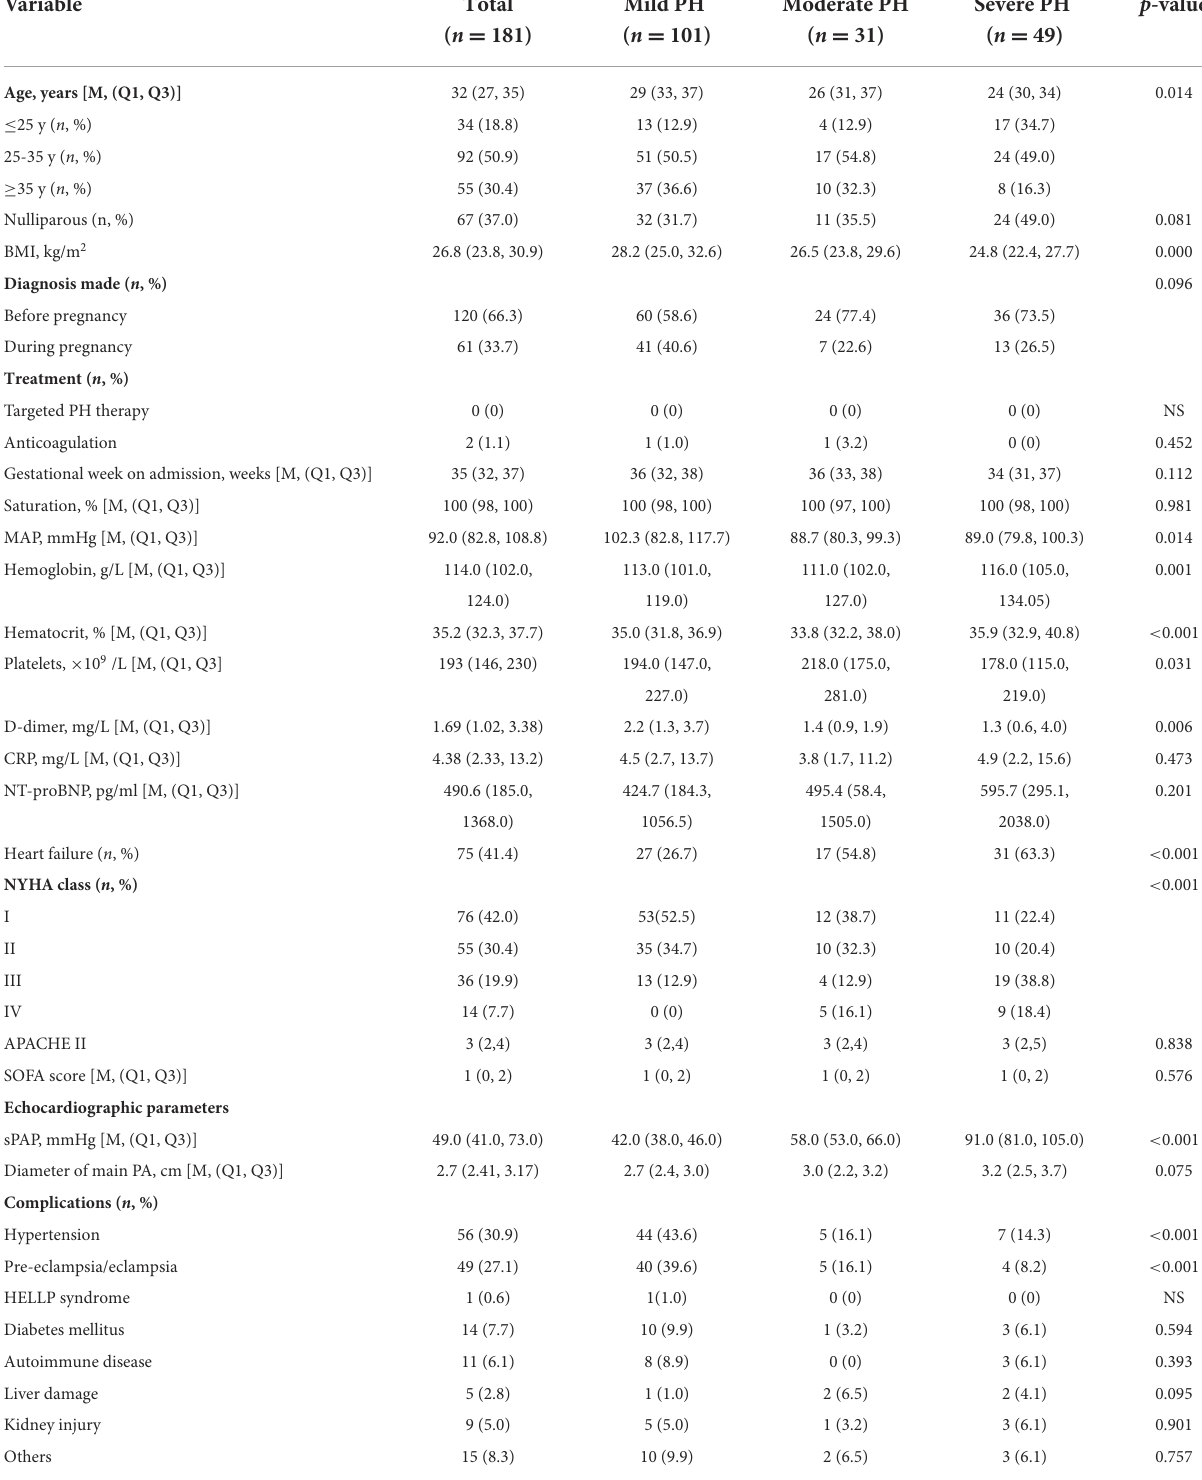
TABLE 1 Baseline characteristics of pregnant women based on PH severity diagnosed via